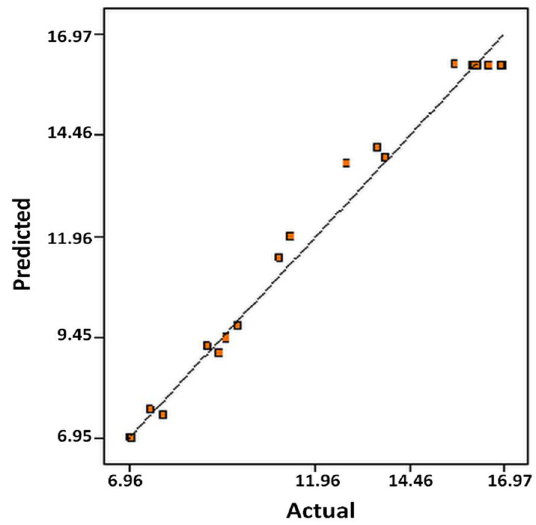
Figure 4. Observed versus actual values of organic acids production according to the experimental design for the mixed anaerobic culture.